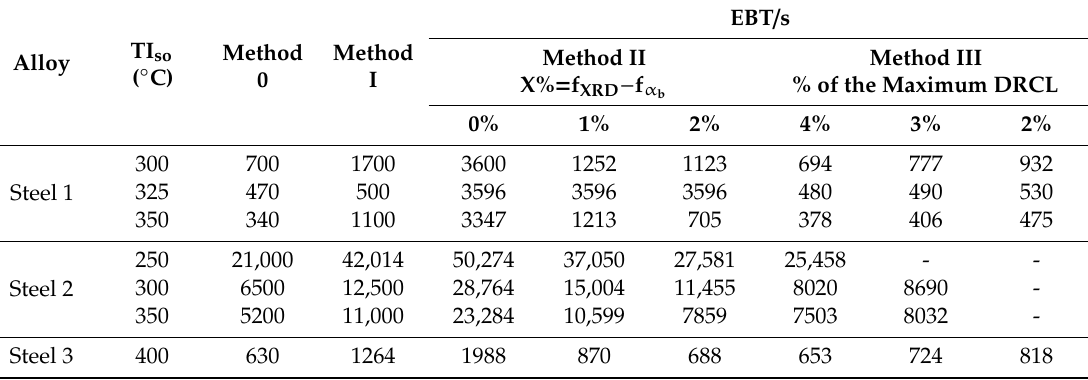
Table 4. Summary of results of the EBT (in s) obtained by the di ff erent methods discussed in this paper. The results obtained according to Method 0 are an approximation for the shortest time from where there is no more bainitic transformation detectable by means of XRD and HV measurements, i.e., beginning of Region 3. DRCL stands for the derivative of the relative change in